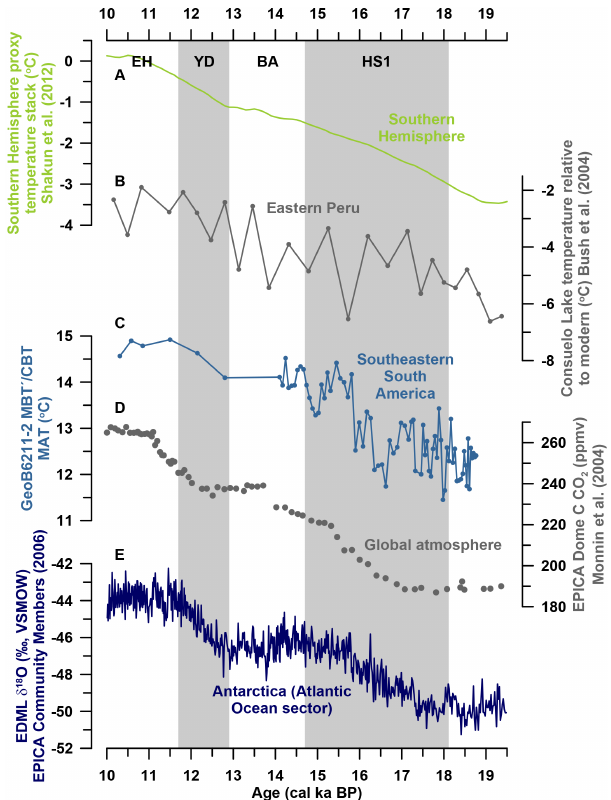
Figure 6. Millennial-scale variability of the mean air temperature of southeastern South America spanning Termination 1 compared to selected available records. (a) Southern Hemisphere proxy tem- perature stack (Shakun et al., 2012). (b) Lake Consuelo pollen- based temperature anomalies relative to modern conditions (Bush et al., 2004). (c) GeoB6211-2 methylation of branched tetraether (MBT’)- and cyclization of branched tetraether (CBT)-based mean air temperature (MAT). (d) EPICA Dome C (Monnin et al., 2004) atmospheric CO 2 plotted versus its original chronology. (e) EPICA Dronning Maud Land (EPICA Community Members, 2006) δ 18 O plotted versus its original chronology. Grey vertical bars depict Heinrich Stadial 1 (HS1) (Sarnthein et al., 2001) and the Younger Dryas (YD) (Rasmussen et al., 2006). BA: Bølling–Allerød; EH: early